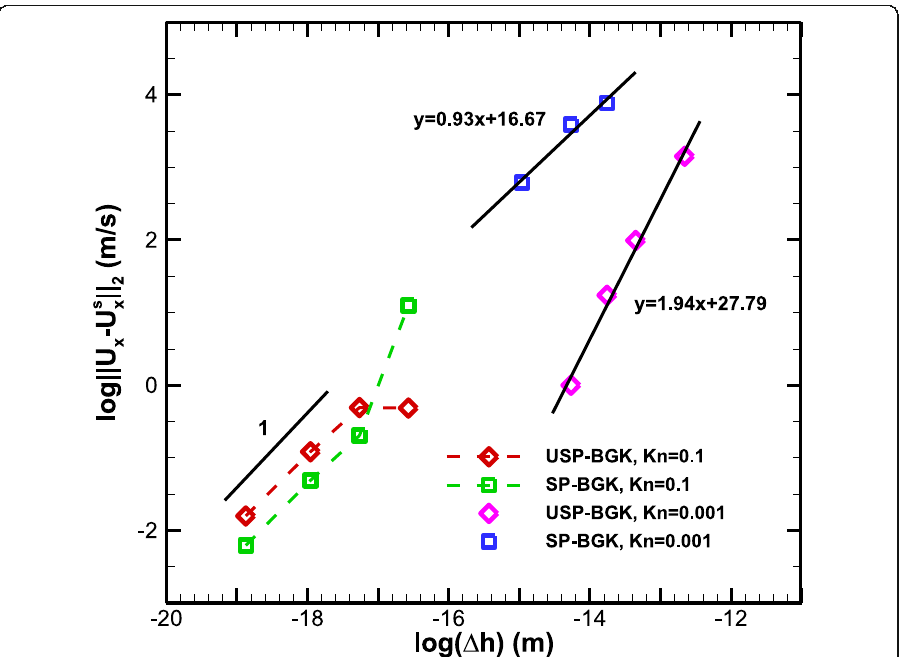
Fig. 3 L 2 -norm of the U x -errors in Poiseuille flow obtained by the USP-BGK and SP-BGK methods in the continuum ( Kn = 0.001) and rarefied ( Kn = 0.1) flow